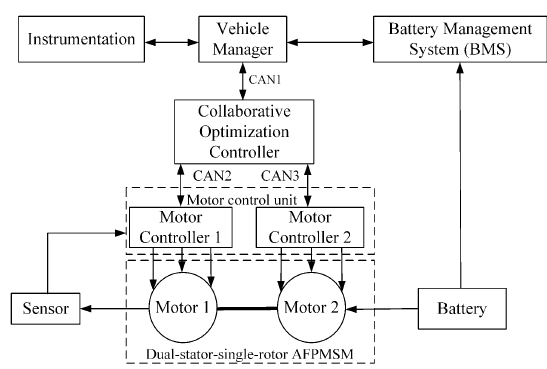
Figure 34 Efficiency optimization control strategy system topology